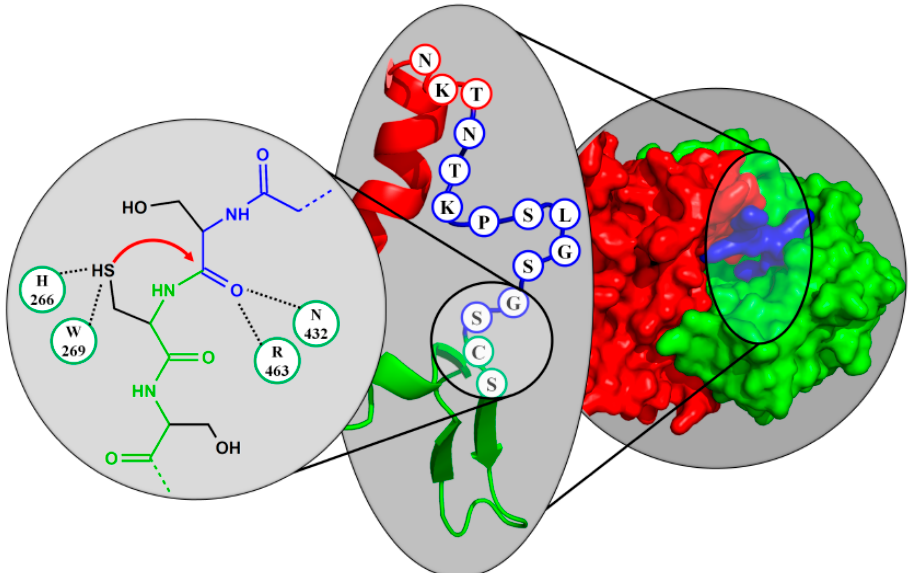
Figure 4. Sequence-related-function of Plbd2 active site and the disposable linker peptide. The crystal structure (predicted by alpha fold on the basis of UniProtKB Q3TCN2) represents the murine Plbd2 protein, consisting of the α -subunit marked in red, the β -subunit marked in green, and the disposable linker peptide marked in blue (background). The linker is sterically blocking the active pocket and, thus, needs to be detached from the precursor to activate the enzyme. The zoom into the linker region unveils the N-terminal nucleophile (C = cysteine 249), which is needed for autocatalytic cleavage of the linker peptide (foreground), according to PDB 3FGR. H266 and W269 stabilize the nucleophile; N432 and R463 form the oxyanion